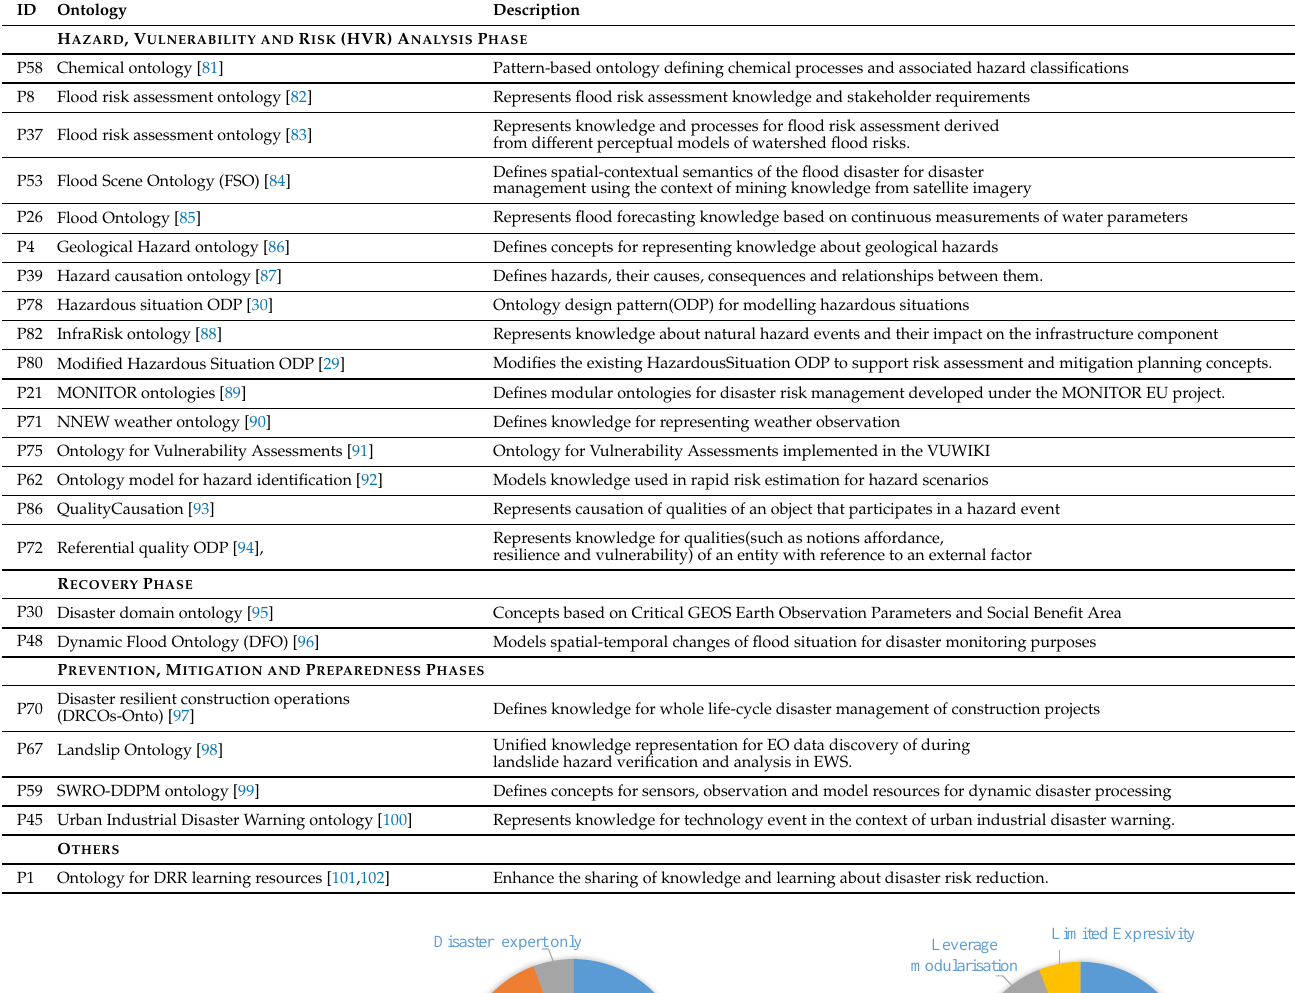
Table 5. HVR, Preparedness, Recovery and other DRR Ontologies.